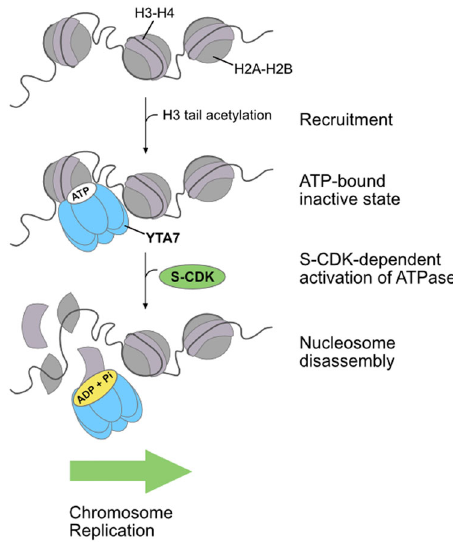
Fig. 6 Model of Yta7 chromatin segregase mechanism and regulation. Recruitment of Yta7 to chromatin is facilitated by H3 acetylation. In the S phase, Yta7 is phosphorylated by CDK, which stimulates its ATPase activity. Hydrolysis of ATP is then necessary to segregate histones from DNA. This cell cycle-regulated alleviation of the chromatin barrier promotes S phase chromosome replication to preserve genome stability. See text for